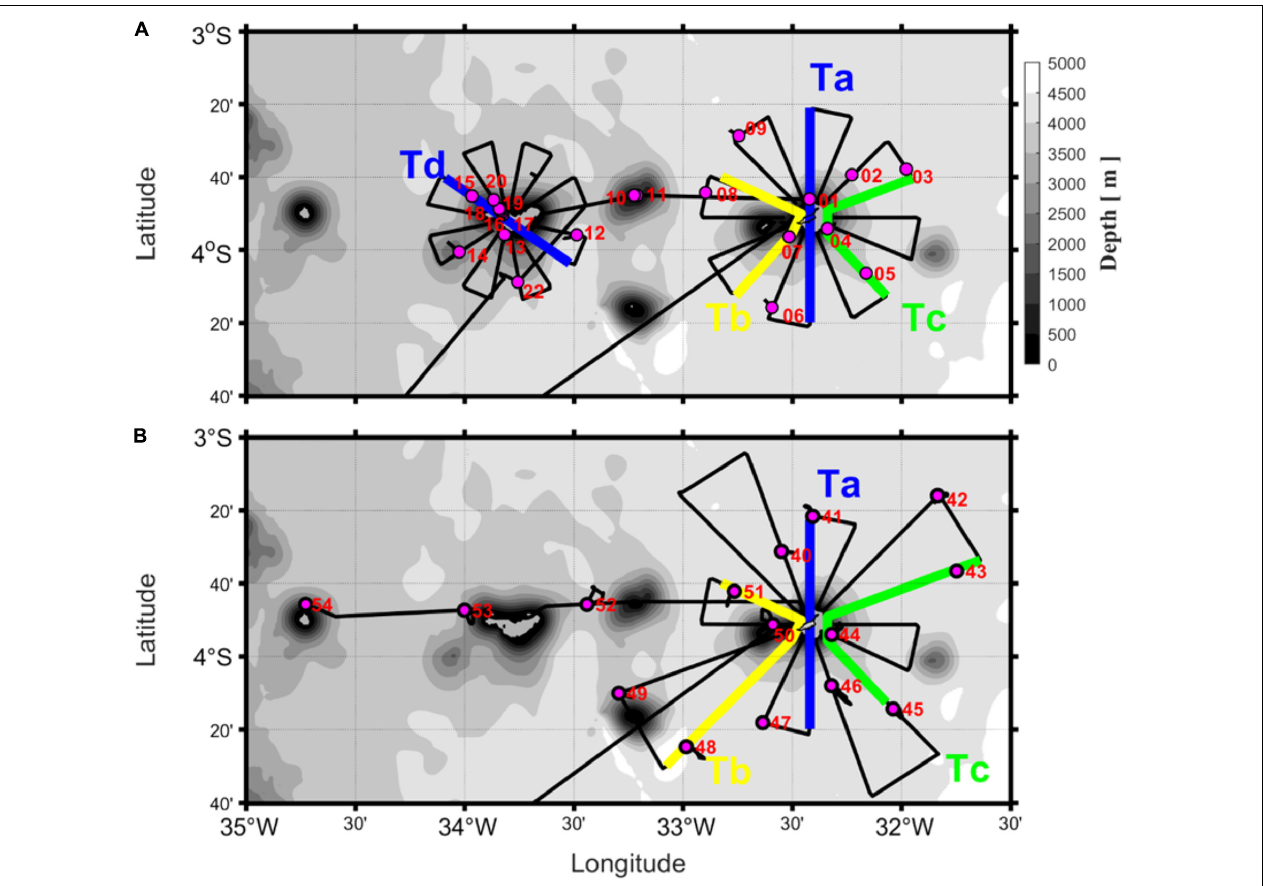
FIGURE 2 | Bathymetric maps of the study area with SADCP sections (black solid lines) acquired during ABRAÇOS 1 in spring 2015 (A) and ABRACOS 2 in fall 2017 (B) . The thick blue lines (Ta) indicate the transect detailed in section “Circulation Patterns.” The thick yellow lines (Tb), the thick green lines (Tc) and the thick blue lines (Td) indicate the transects discussed in section “Discussion.” Pink dots show the positions of the CTD